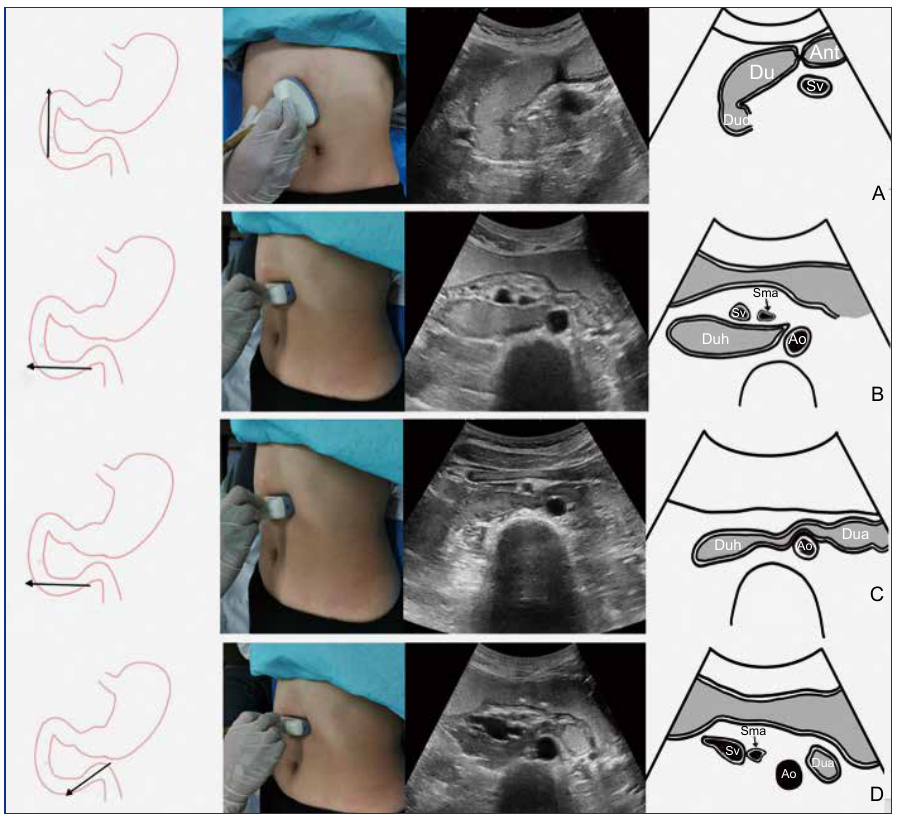
Figure 6 The imaging sections of the duodenum. (A) The section of duodenal bulb, descending part, horizontal part (transverse oblique section of right upper abdomen in supine position); (B) The section of horizontal part of the twelfth rectum (oblique cross section of abdomen above umbilicus in supine position); (C and D) The section of ascending part of duodenum (vertical transverse section of abdomen above umbilicus in supine position). Du, duodenal bulb; Dud, descending part of duodenum; Duh, duodenal horizontal part; Dua, duodenal ascending part; Sma, superior mesenteric artery; Sv, spleen vein; Ao, abdominal aorta.